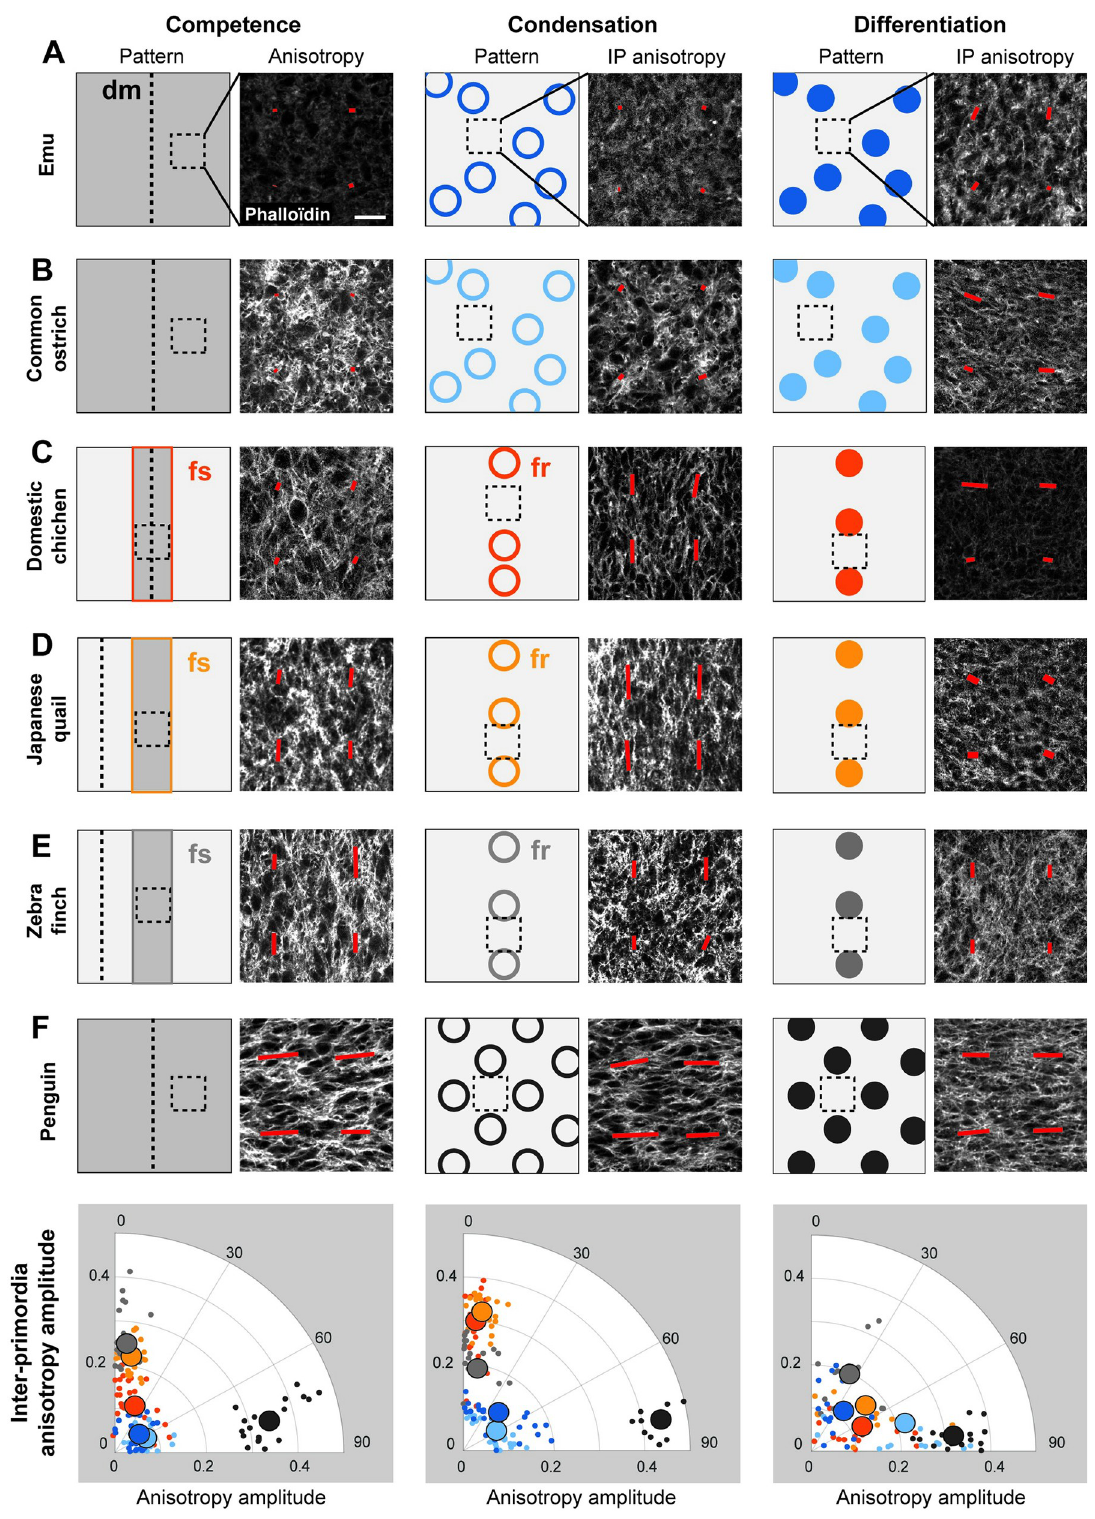
Fig 3. Dermal cell anisotropy amplitude correlates with primordia array geometry. (A–F) For each column (left, competence stage; middle, condensation stage; right, differentiation stage), left panels show schematics of the embryonic skin in emu (A), common ostrich (B), domestic chicken (C), Japanese quail (D), zebra finch (E), and penguin (F) embryos. Black dotted lines indicate the position of